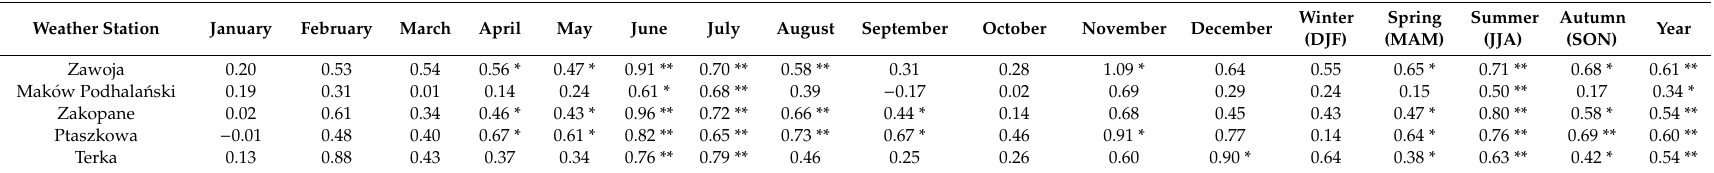
Table 4. Trend intensity a ( ◦ C per decade) in minimum air temperature (TAmin) for each month, each season (1984–2018) and for the annual means (the last column). Weather Station